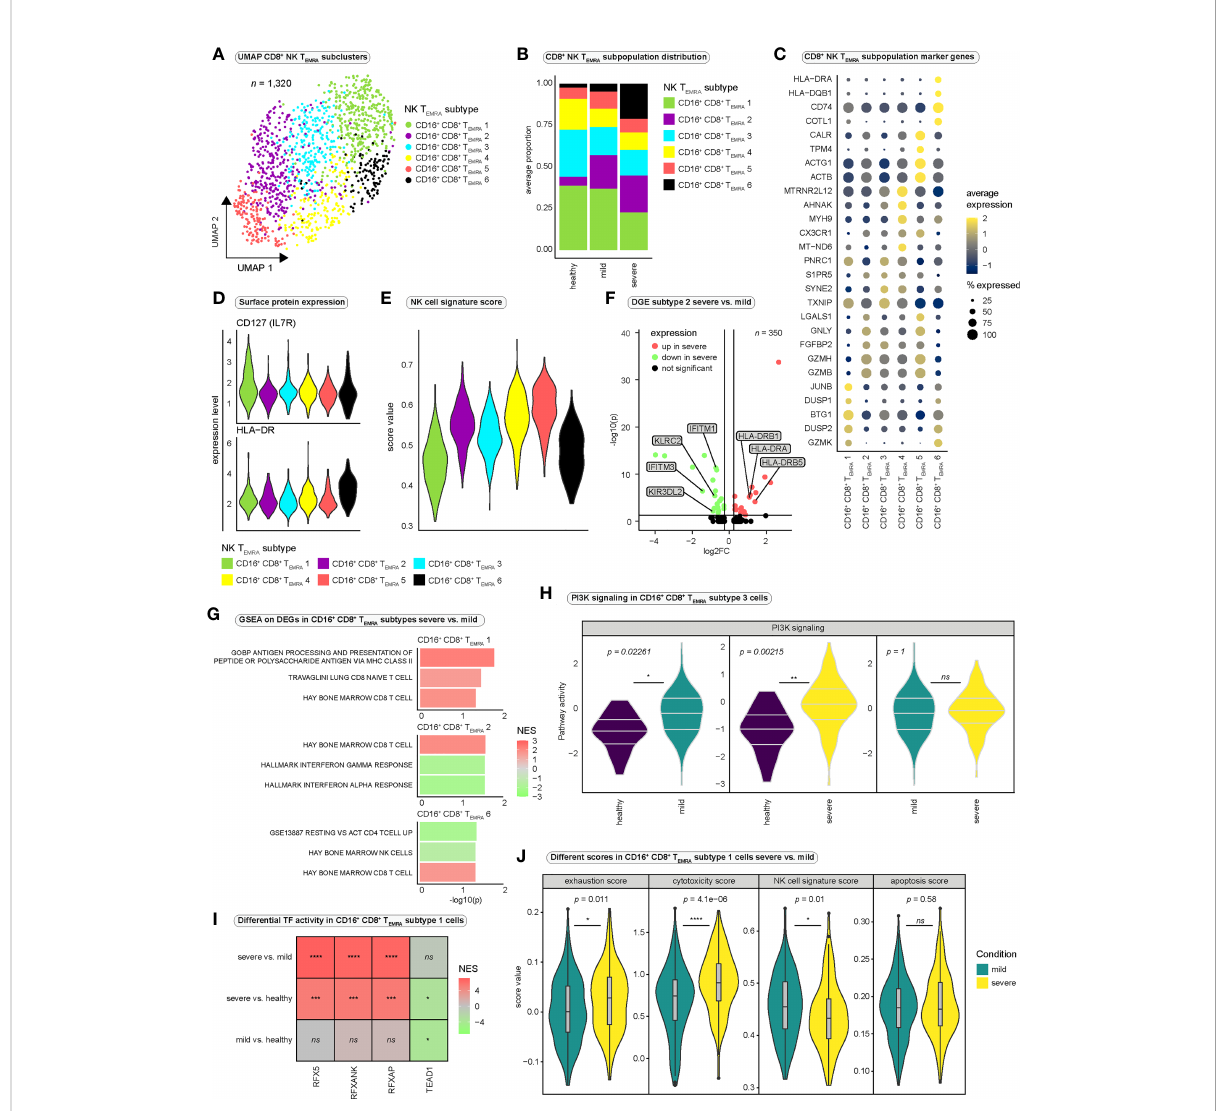
FIGURE 5 Heterogeneity among CD8 + NK-like terminally differentiated effector memory T cells re-expressing CD45RA. (A) Integrated UMAP projection of subclustered CD8 + NK-like T EMRA cells (CD16 + CD8 + T EMRA cells) ( n = 1,320). (B) Average proportion of CD16 + CD8 + T EMRA subsets for the three conditions. Cell type proportions per patient are reported in Figure S6A. (C) Average expression of marker genes differentially expressed in the six CD16 + CD8 + T EMRA subsets. (D) Surface expression (CITE-seq) of IL7R and HLA-DR per CD16 + CD8 + T EMRA subtype. (E) NK cell signature scores of the six CD16 + CD8 + T EMRA subsets. (F) Differentially expressed genes in CD16 + CD8 + T EMRA -2 cells between the severe and the mild disease condition. (G) Selected signi fi cantly enriched gene sets for genes differentially expressed in the indicated CD16 + CD8 + T EMRA subtypes between mild and severe disease groups. Positive normalized enrichment scores (NES) indicate enrichment in the severe disease condition. (H) PI3K pathway activity in CD16 + CD8 + T EMRA -3 cells estimated with PROGENy. Signi fi cance was tested using Wilcoxon rank sum test. All PROGENy pathways are reported in Figure S6G. (I) Differential transcription factor activity (DoRothEA) estimated with msviper in CD16 + CD8 + T EMRA -1 cells between the severe and the mild condition. Positive NES values indicate increased activity in severe SARS-CoV-2 infection. (J) Different functional scores applied to CD16 + CD8 + T EMRA -1 cells and compared between severe and mild COVID-19 (Wilcoxon rank sum test). DGE, differential gene expression; log2FC, log2 fold change; GSEA, gene set enrichment analysis; NES, normalized enrichment score; PI3K, Phosphoinositide 3-kinase; TF, transcription